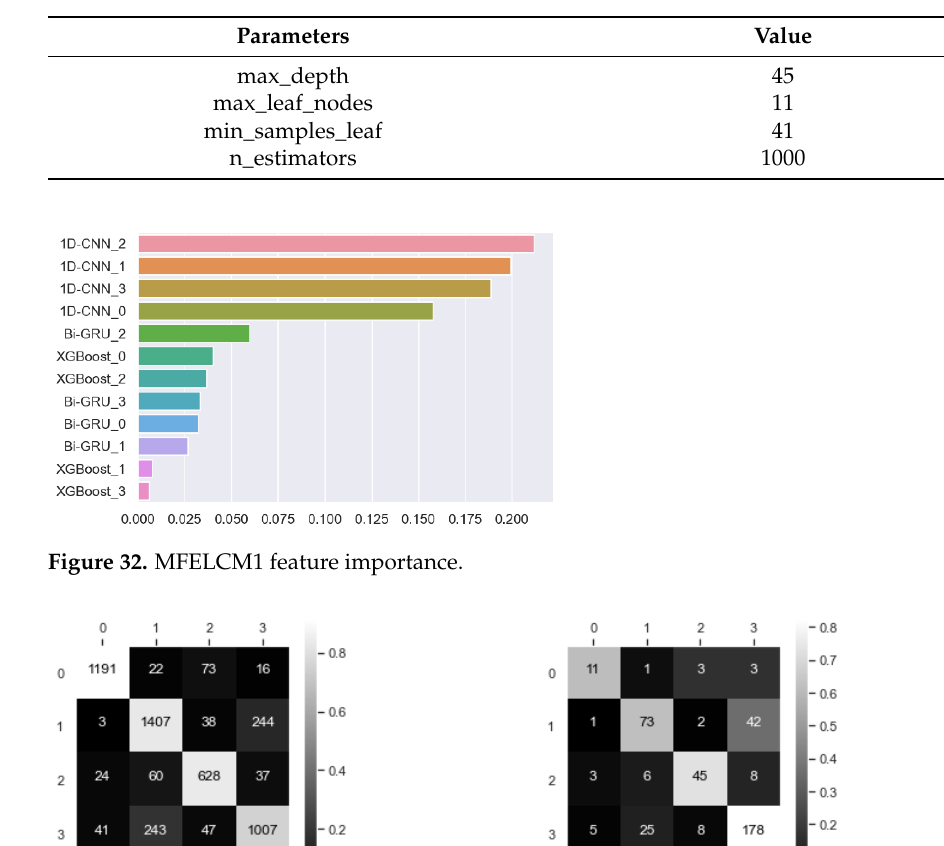
Table 14. Parameters of Random Forest2 (in MFELCM1).